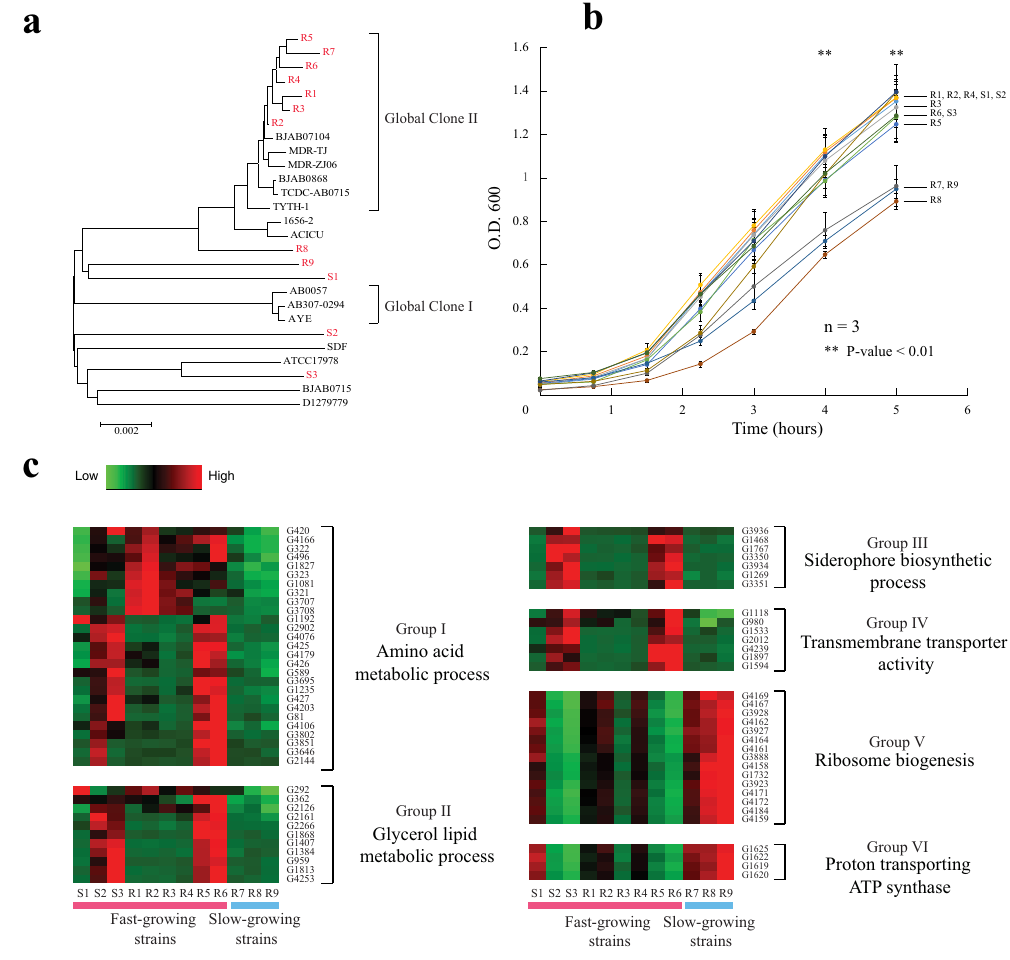
Figure 1. Fast-growing pan-drug-resistant strains exhibited higher nutrition uptake and utilization ability. ( a ) Phylogenetic tree including collected strains and 15 published complete genomes. ( b ) Growth curves of 12 strains in BHI broth over 5 hours. Error bars: standard error. p -values were calculated by Student’s t -test. ( c ) Heat map of differentially expressed genes between fast-growing strains and slow-growing strains, classified by functional